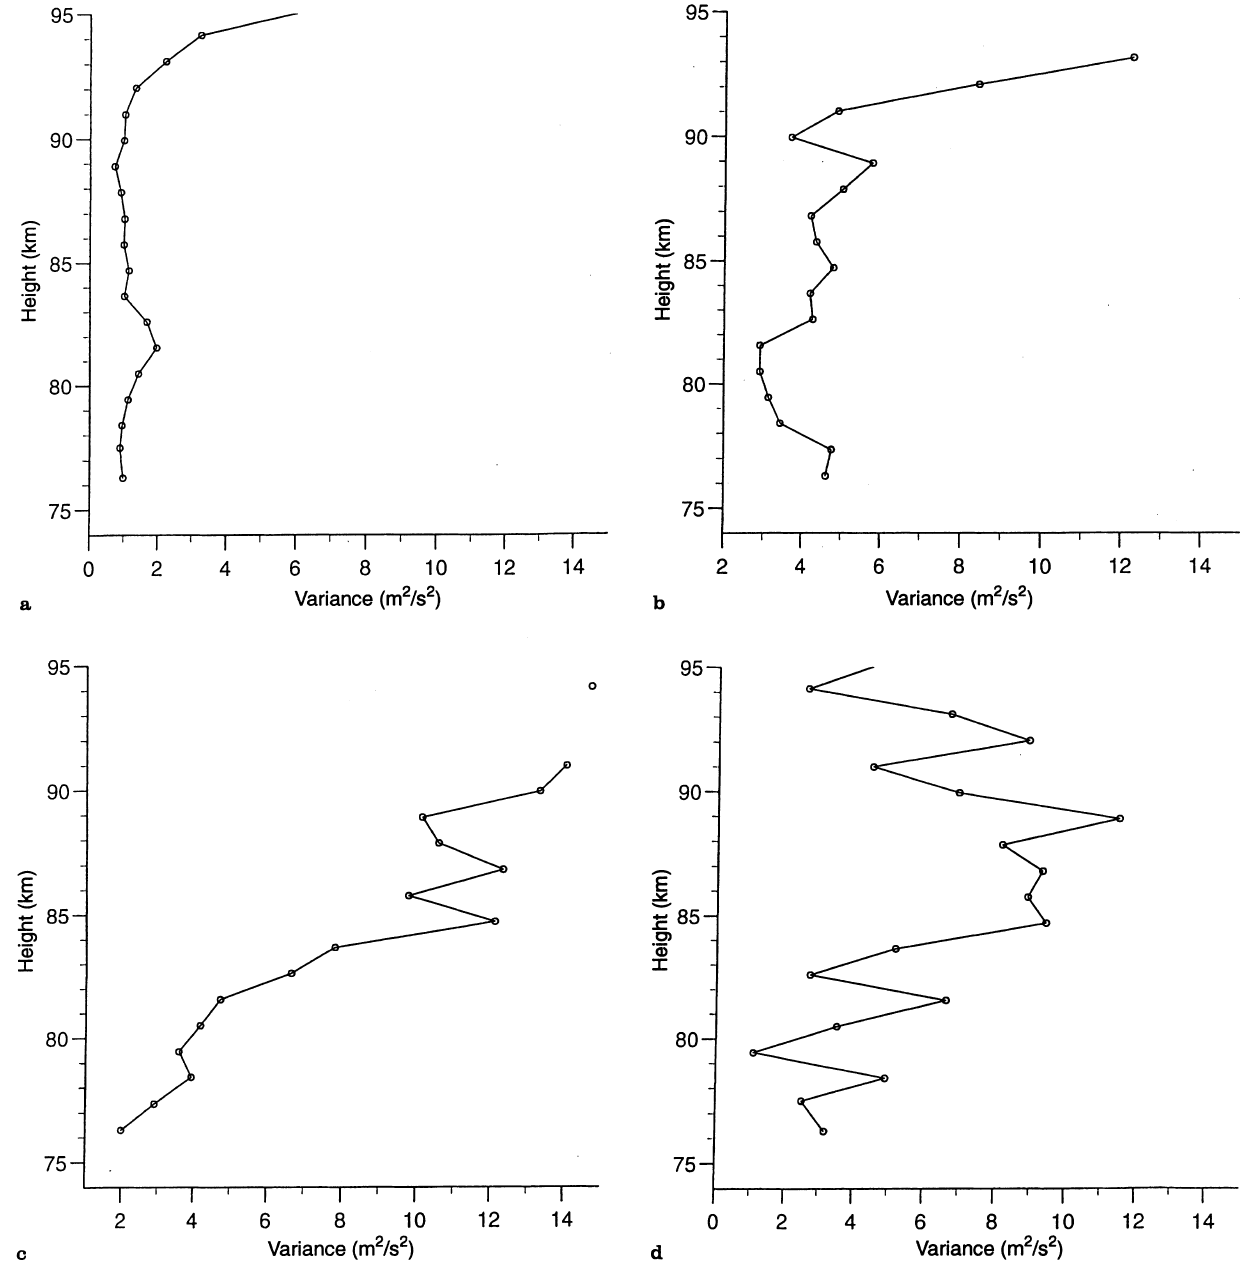
Fig. 4. Profiles of the daily-mean variance of vertical velocity for a 4 June, 1991; b 31 July, 1990; c 27 August, 1990 and d 25